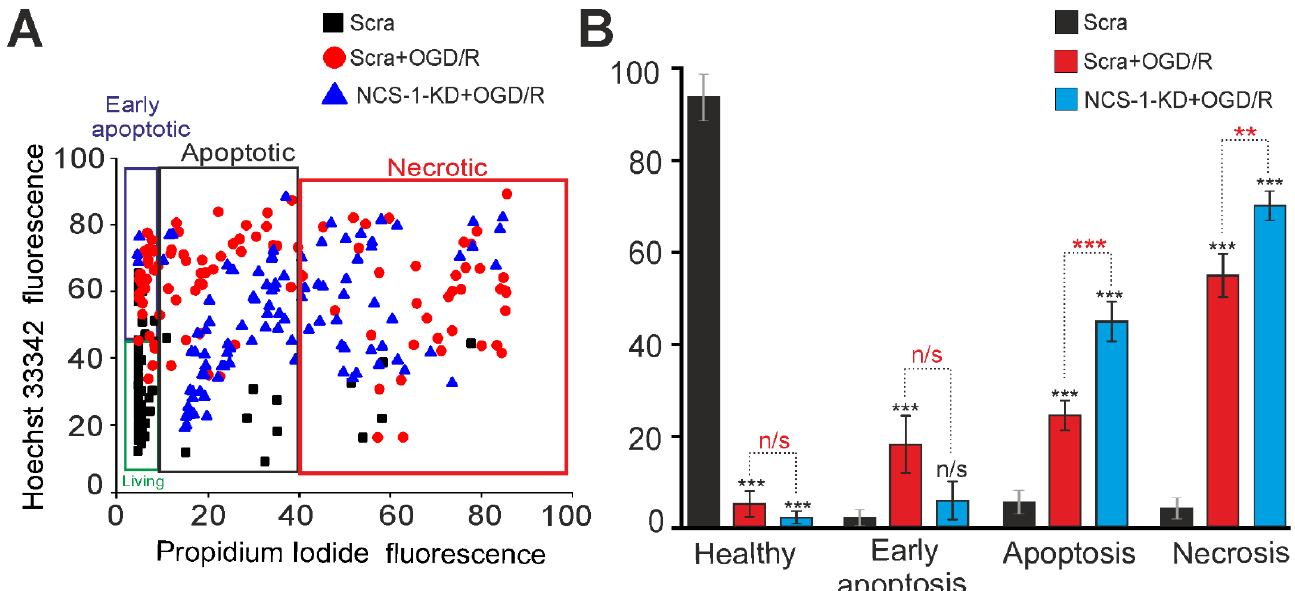
Figure 3. Effect of NCS-1-KD on the viability of cortical cells after 2 h of OGD exposure and 24 h of reoxygenation (OGD/R conditions). ( A ) Cytogram demonstrating the viability of cortical cells in the Control (Scra, without OGD/R) and after OGD/R in the Scra and NCS-1-KD groups. ( B ) Effects of NCS-1-KD on the induction of necrosis and apoptosis after 24 h OGD/R. Viable cells are not permeable to PI, while Hoechst 33,342 penetrates through the plasma membrane, staining the chromatin. Cortical cells were defined as apoptotic if the intensity of Hoechst 33,342 fluorescence was 3 – 4 times higher compared to Hoechst 33,342 fluorescence in healthy cells, indicating chromatin condensation, which can occur as a result of apoptosis induction. The differences between the early and late stages of apoptosis were determined by the intensity of Hoechst 33,342 fluorescence, and at the later stages of apoptosis, cells begin to show insignificant membrane permeability for PI. Statistical significance was assessed using unpaired t-test. Comparison of experimental groups relative to Scra: n/s — data not significant ( p > 0.05) and *** p < 0.001 marked in black. Comparison of Scra + OGD/R with NCS-1-KD + OGD/R: n/s — data not significant ( p > 0.05), *** p < 0.001 and ** p < 0.01, marked in red. The number of samples is 5. N (number of animals used for cell cultures preparation) = 3.